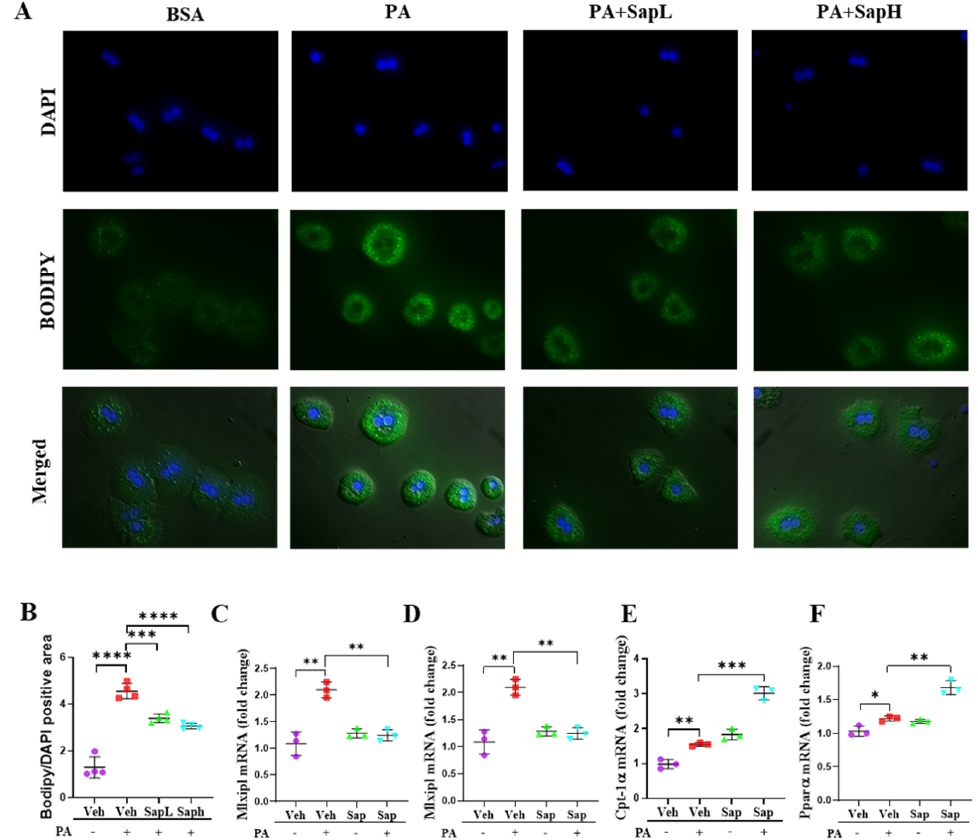
Figure 2. Saponin extract improved the FFD-induced hepatic steatosis in vitro. ( A ) Lipid accumulation was assessed by BODIPY staining in primary hepatocyte. ( B ) The quantification of the BODIPY/DAPI-positive area. Expression of lipogenesis genes ( C ) Mlxipl and ( D ) sterol regulatory element-binding protein (Srebp-1c) and fatty acid oxidation genes marker ( E ) Srebp-1c and ( F ) Pparα were measured by qRT-PCR in the primary hepatocyte. Relative mRNA expression levels were normalized to mouse GAPDH levels. The data are expressed as means ± sem. * p < 0.05, ** p < 0.01, *** p < 0.001, and **** p < 0.0001.